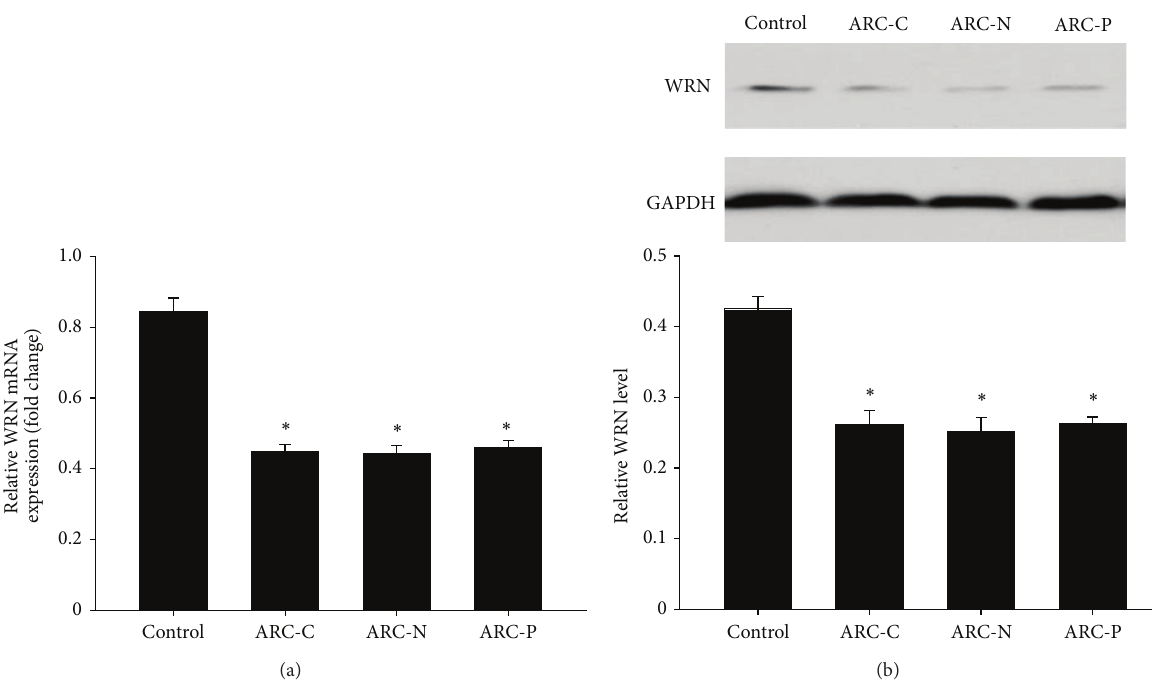
Figure 1: Relative expression of mRNA and protein levels of WRN in anterior lens capsules of control and ARC. (a) RT-PCR analysis of the expression of WRN in control ( 𝑛 = 20 ) and ARC-C ( 𝑛 = 20 ), ARC-N ( 𝑛 = 20 ), and ARC-P ( 𝑛 = 20 ). Values represent mean ± SD. ∗ 𝑃 < 0.01 . (b) WRN protein levels in control ( 𝑛 = 9 ) and ARC-C ( 𝑛 = 9 ), ARC-N ( 𝑛 = 9 ), and ARC-P ( 𝑛 = 9 ) anterior lens capsules were detected using Western blotting. Relative WRN protein level to GAPDH is presented as mean ± SD. ∗ 𝑃 < 0.01